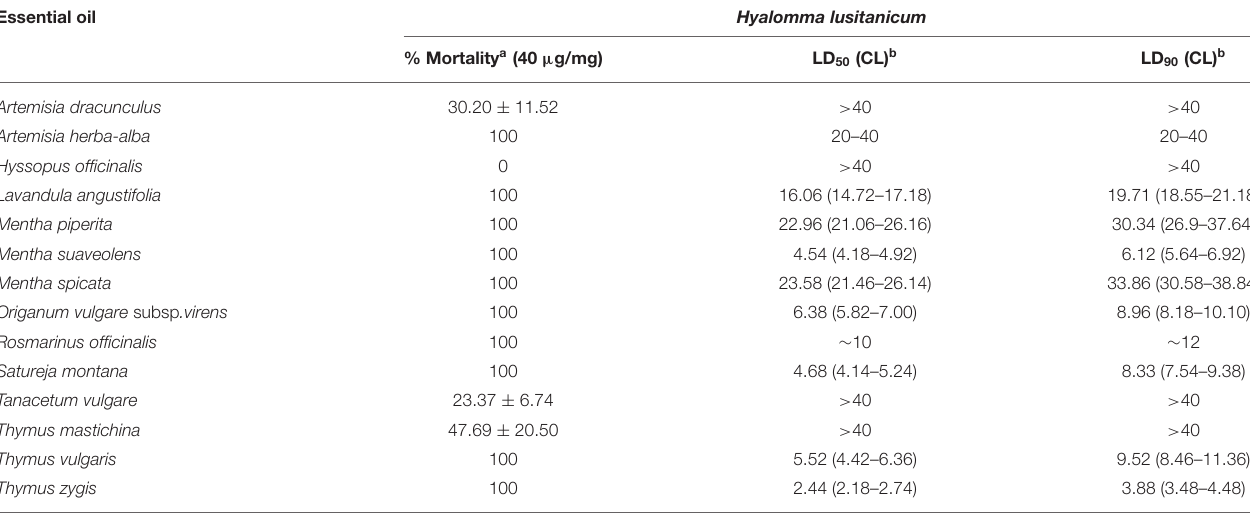
TABLE 2 | Larvicidal effects of the selected essential oils on Hyalomma lusitanicum . Essential